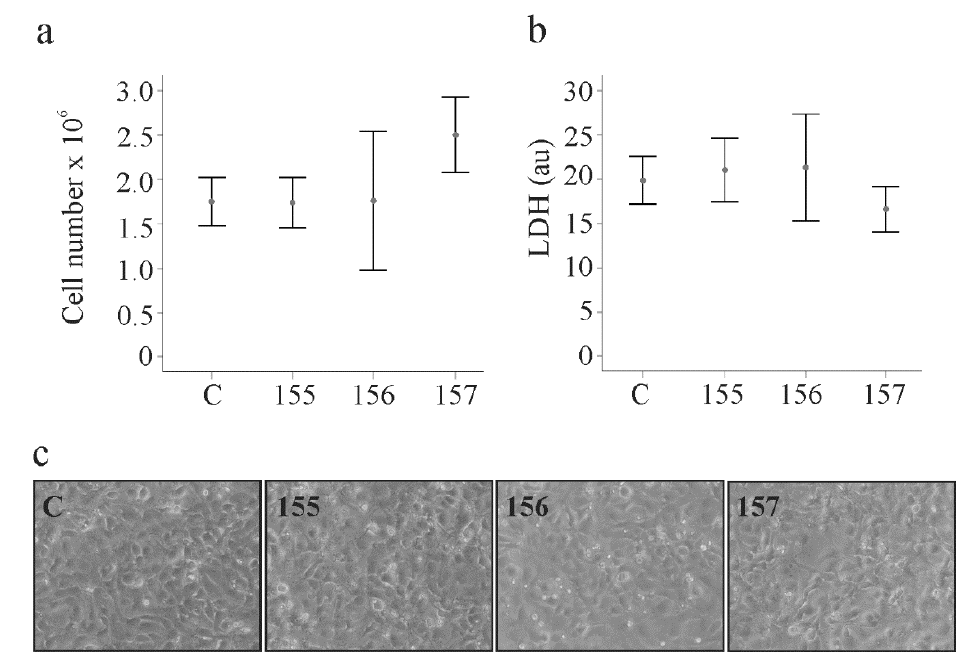
Figure 3. Chemerin isoform effects on cell proliferation, lactate dehydrogenase and cell morphology. ( a ) LX-2 cells were transfected with an insertless plasmid (C) and plasmids to express huChem-155, 156 and 157. Cell number was counted at 48 h post-transfection ( n = 3); ( b ) Lactate dehydrogenase (LDH) in the supernatants of the cells described in a ( n = 4). ( c ) Morphology of the transfected cells.